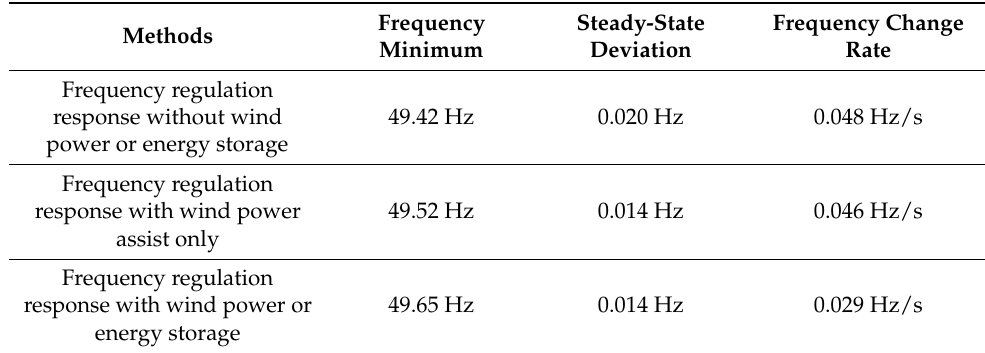
Figure 12. Frequency characteristics comparisons of frequency regulation methods.